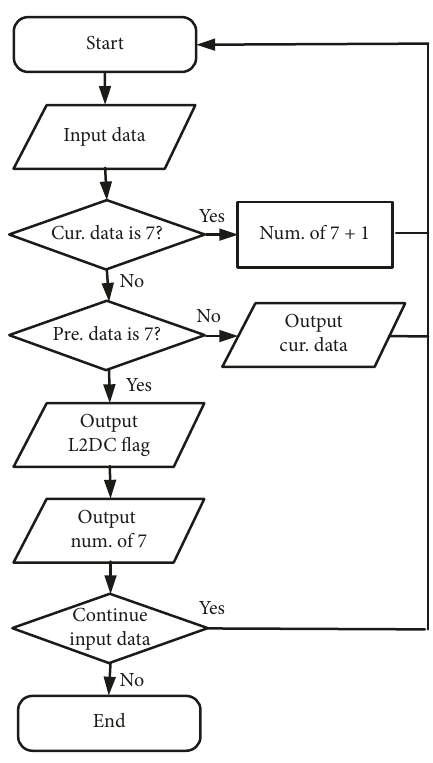
Figure 12: Example of operating flow of changing L1DC data pattern to L2DC data pattern.